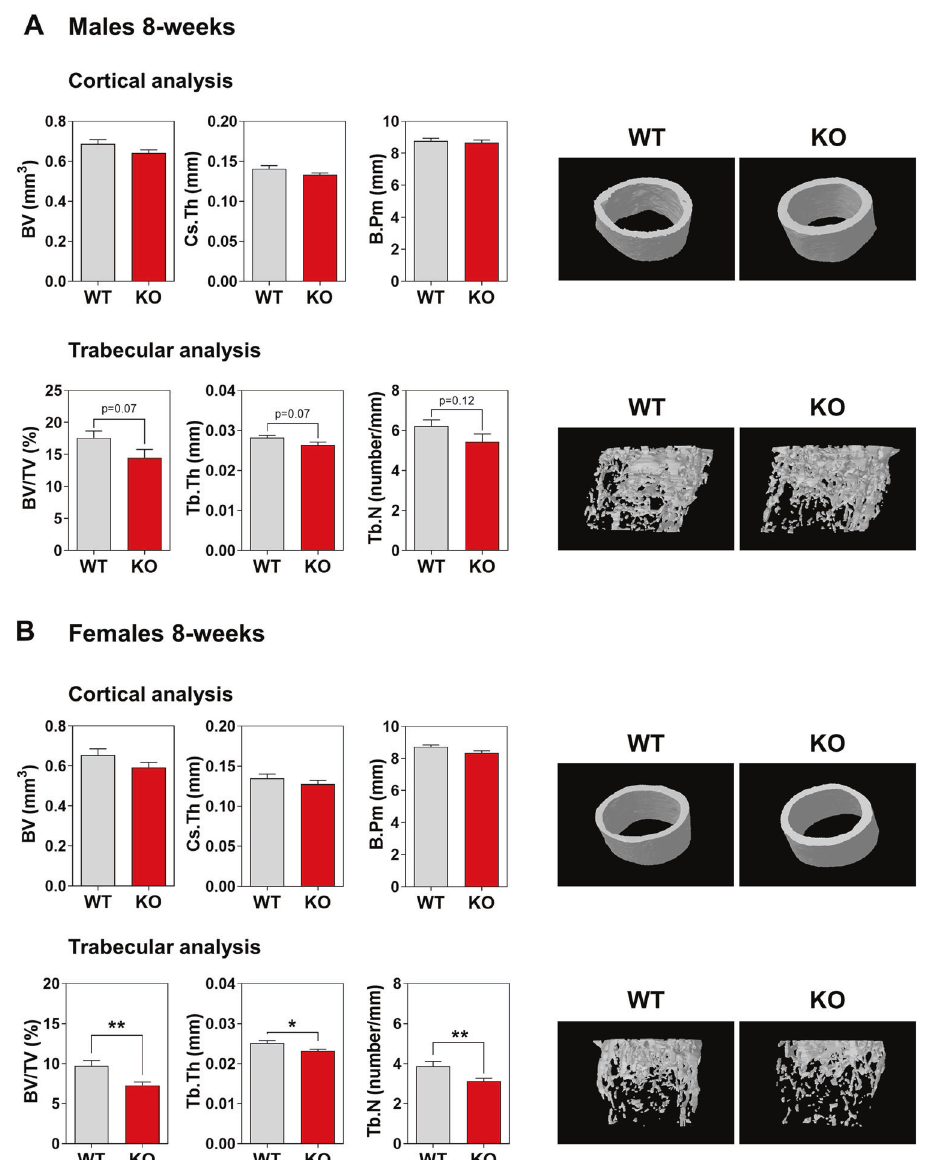
Fig. 3 Female-associated osteopenia in young Herc1 -knockout mice. Bone composition by micro-CT analysis of 8-week-old mice. Cortical and trabecular analysis of distal femurs from male ( A ) and female ( B ) mice. Representative images are shown. Data are expressed as mean ± SEM ( n = 8 – 12). Signi fi cant differences are relative to WT mice of the same sex. * p < 0.05; ** p < 0.01. BV bone volume, B.Pm bone perimeter, BV/TV bone volume over total volume, Cs.Th cortical thickness, Tb.N trabecular number, Tb.Th trabecular thickness, KO knockout, WT